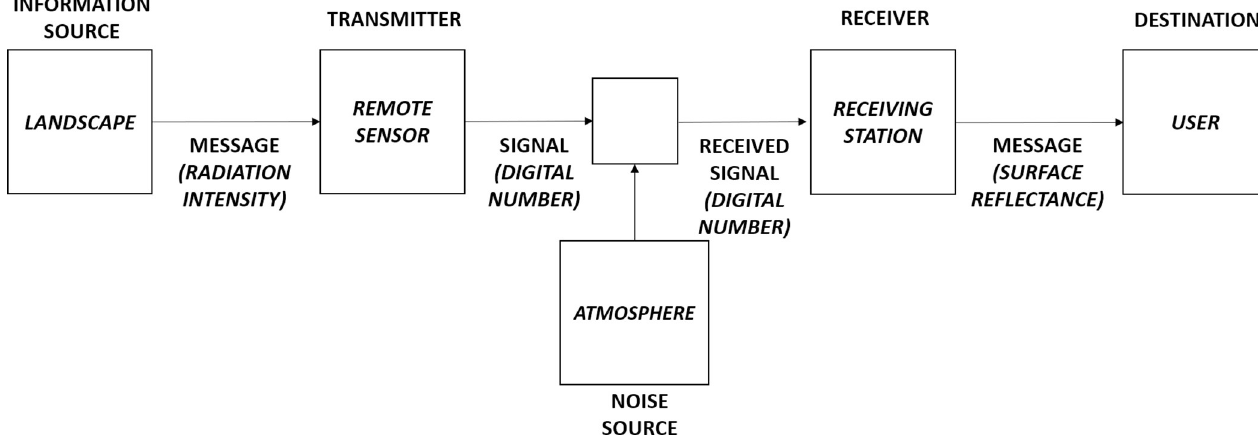
Fig 2. Shannon’s schematic diagram of a general communication system, adapted for information flow in remote sensing (satellite). (Modified by the authors from Shannon [28]).